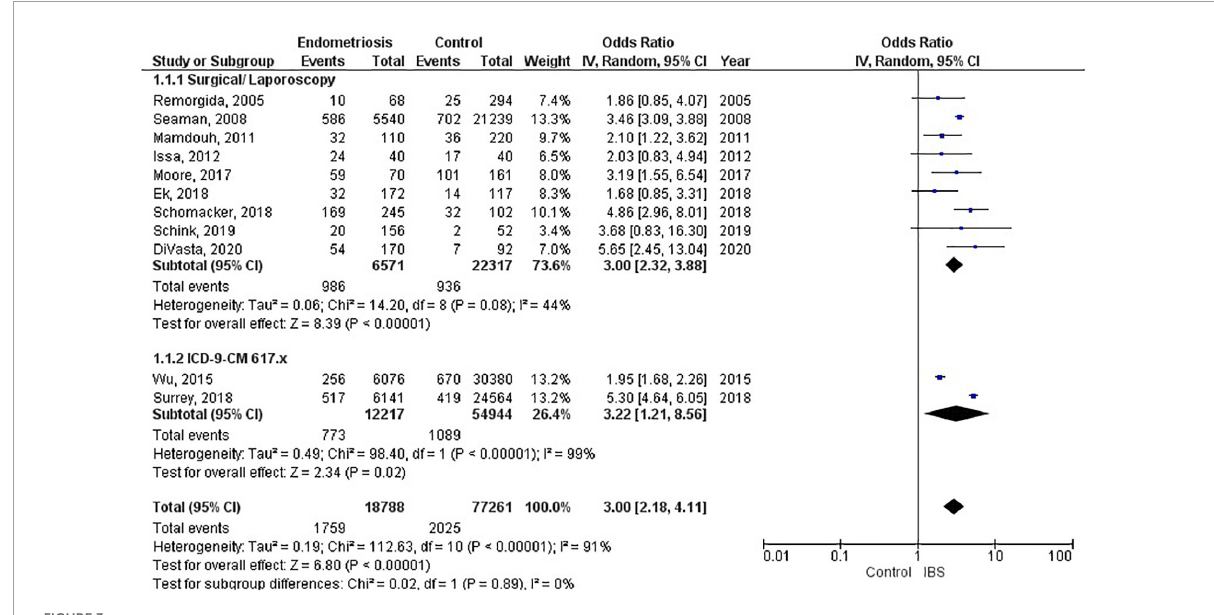
FIGURE3 Forest plot by endometriosis